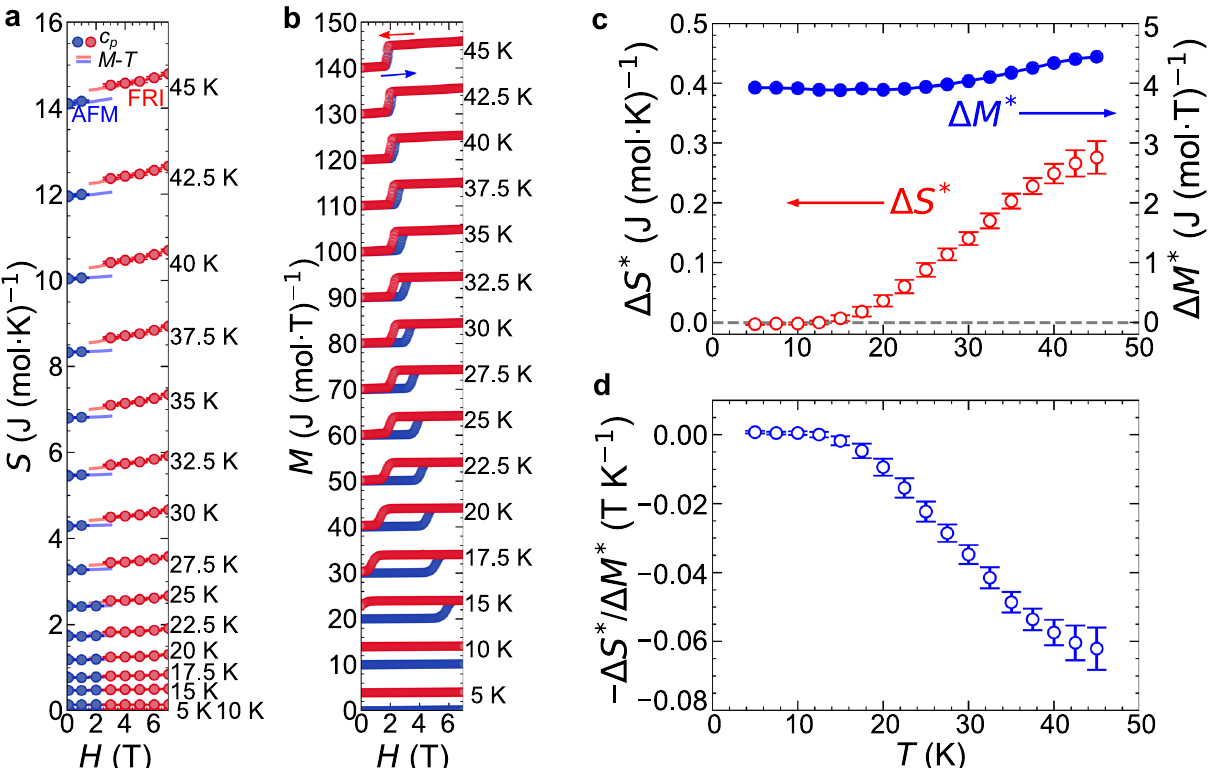
Figure 5. Determination of (cid:31) S ∗ and (cid:31) M ∗ . ( a ) Isothermal entropy curves at selected temperatures. Closed circles are the data obtained from the specific heat measurements. Blue and red solid lines indicate the fittings for the AFM and the FRI phases, respectively, based on the M − T curve and the Maxwell relation. The error bars are estimated from the least-squares fitting. ( b ) Isothermal magnetization curves at selected temperatures. Each magnetization curve is shifted by 10 J/(mol T) for visibility. ( c ) Temperature dependence of the entropy and magnetization changes on the determined phase boundary. d Temperature dependence of the ratio of (cid:31) S ∗ and (cid:31) M ∗ . The error bars in ( c ) and ( d ) are estimated from the standard errors of the parameters when performing the least-squares fitting of the cubic function to the dM dT